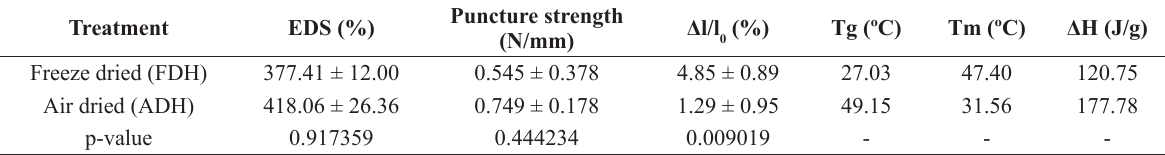
obtained for gelatin